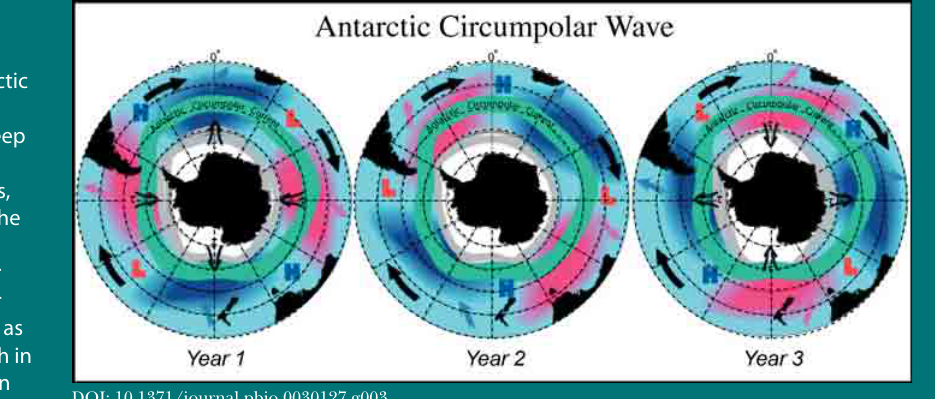
Figure 3. Antarctic Circumpolar Wave In 1996, oceanographers Warren White and Ray Peterson identifi ed signifi cant inter- annual variations in the atmospheric pressure at sea level, wind stress, sea surface temperature, and sea-ice extent over the Southern Ocean. They called this system of coupled anomalies the Antarctic Circumpolar Wave. This simplifi ed schematic summarizes the inter-annual variations in sea surface temperature (red, warm; and blue, cold), atmospheric sea-level pressure (bold H and L), meridional wind stress (denoted by τ), and sea ice extent (gray lines), together with the mean course of the Antarctic Circumpolar Current (green). Heavy black arrows depict the general eastward motion of anomalies, while other arrows indicate communications between the circumpolar current and the more northerly subtropical gyres. (Image: Warren White,